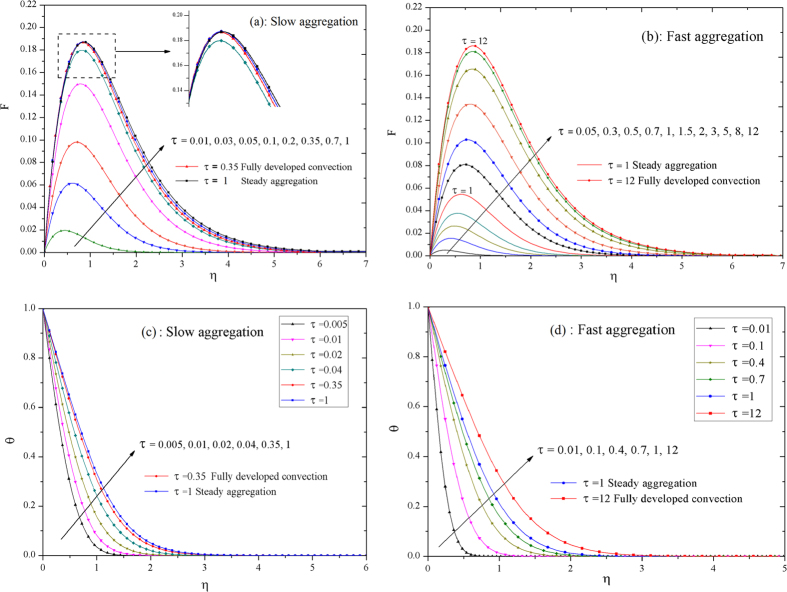
Velocity and temperature profiles by different aggregations for time.The convection velocity and heat transfer are coupled strongly in NCBL2930 that NS undergoes the distinct development of thermal convection due to slow and fast aggregations, respectively. The dimensionless velocity field over time for slow aggregation case in (a) and for fast aggregation case in (b). The dimensionless temperature field for slow aggregation case in (c) and for fast aggregation case in (d), both of them with ϕp = 0.05 & df = 1.8 conditions.